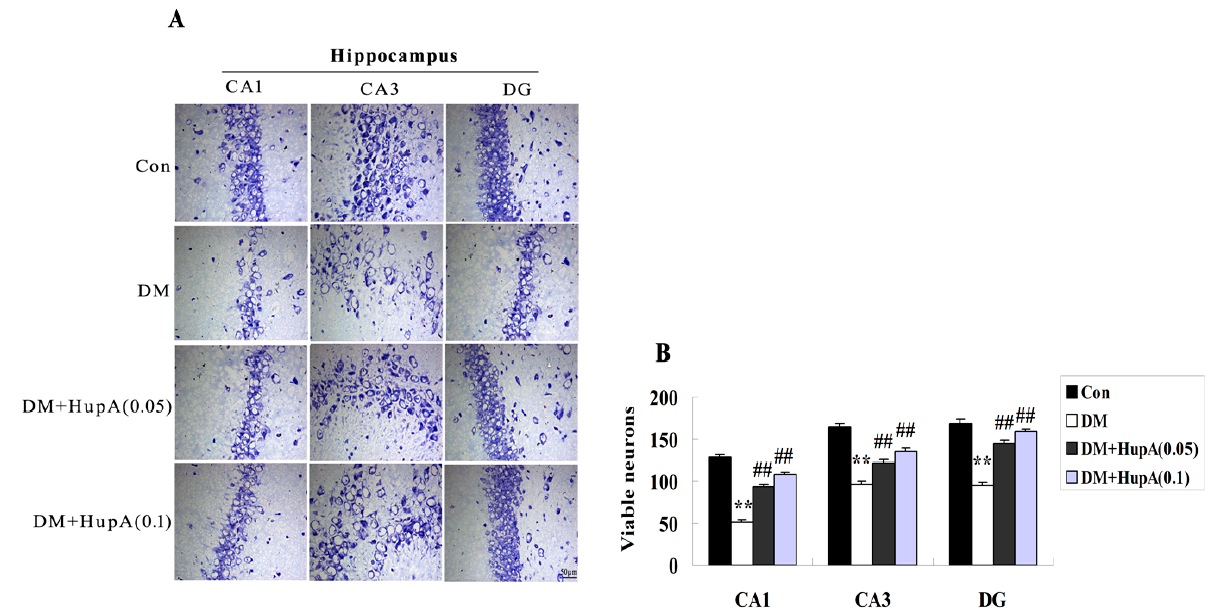
Figure 3. Effects of HupA on the hippocampal neuronal loss control and diabetic rats. ( A ) and ( B ) were the representative photographs of hippocampal neuronal loss and quantitative analysis of viable neurons, respectively. ** p < 0.01 compared with Con group; ## p < 0.01 compared with DM group. Con, control; DM, diabetes; DM + HupA (0.05), huperzine A (0.05 mg/kg)-treated; DM + HupA (0.1), huperzine A (0.1